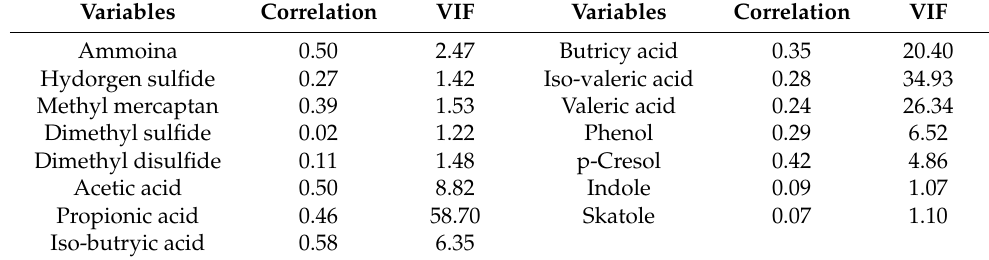
Table 5. Correlation analysis and variance inflation factor (VIF) results.